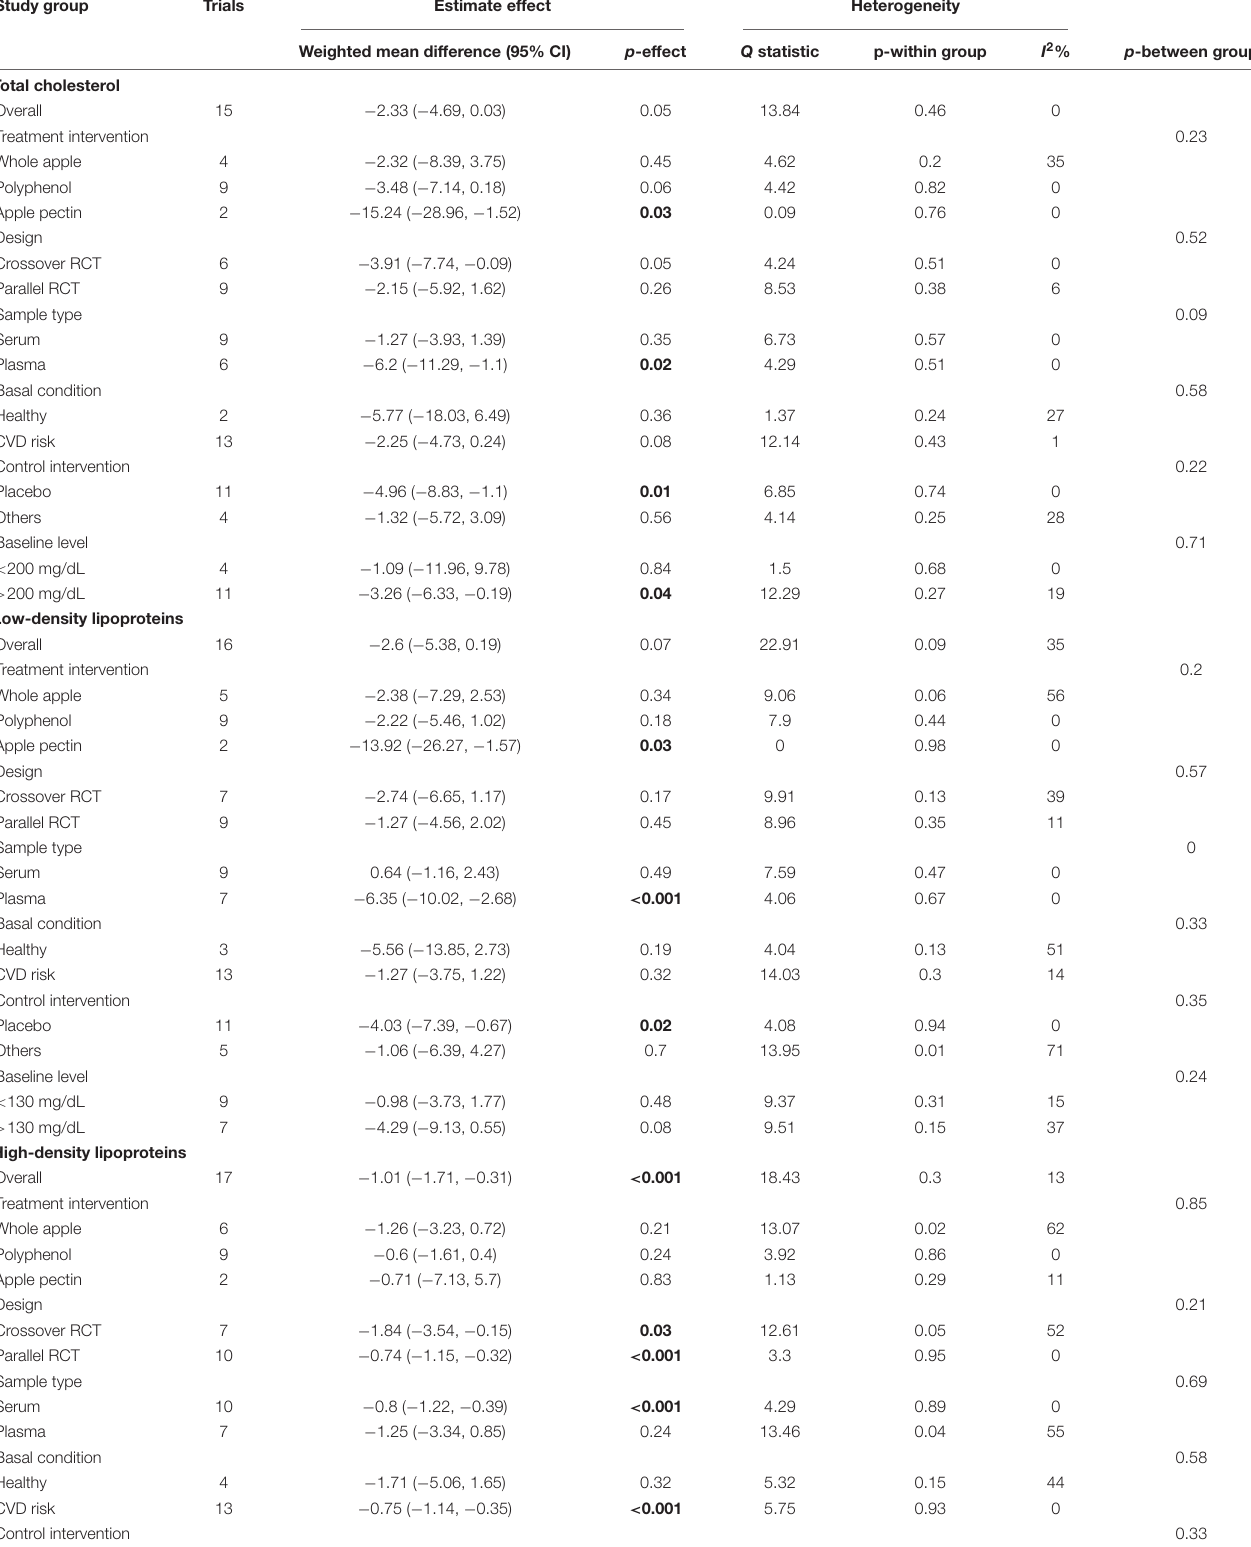
TABLE 4 | Meta-analysis summarization of total cholesterol (TC), low-density lipoprotein (LDL), high-density lipoprotein (HDL), triglycerides (TG), glucose, insulin, c-reactive protein (CRP), diastolic blood pressure (DBP), and systolic blood pressure